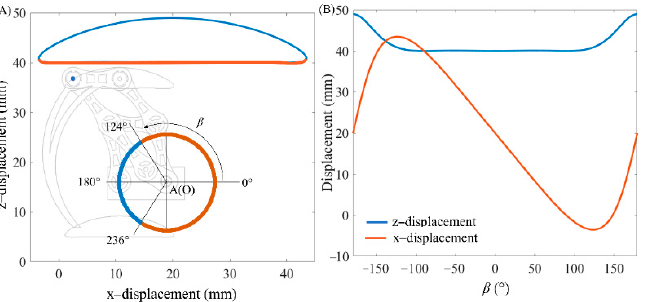
Figure 3. The displacement of point C relative to point A. ( A ) Locomotion trajectory of point C relative to point A (the red part corresponds to the leg in a supported state, β : − 124 ° ~124 ° ; the blue part corresponds to the leg in a swinging state, β : 124 ° ~236 ° ); ( B ) horizontal and vertical displacement of point C.